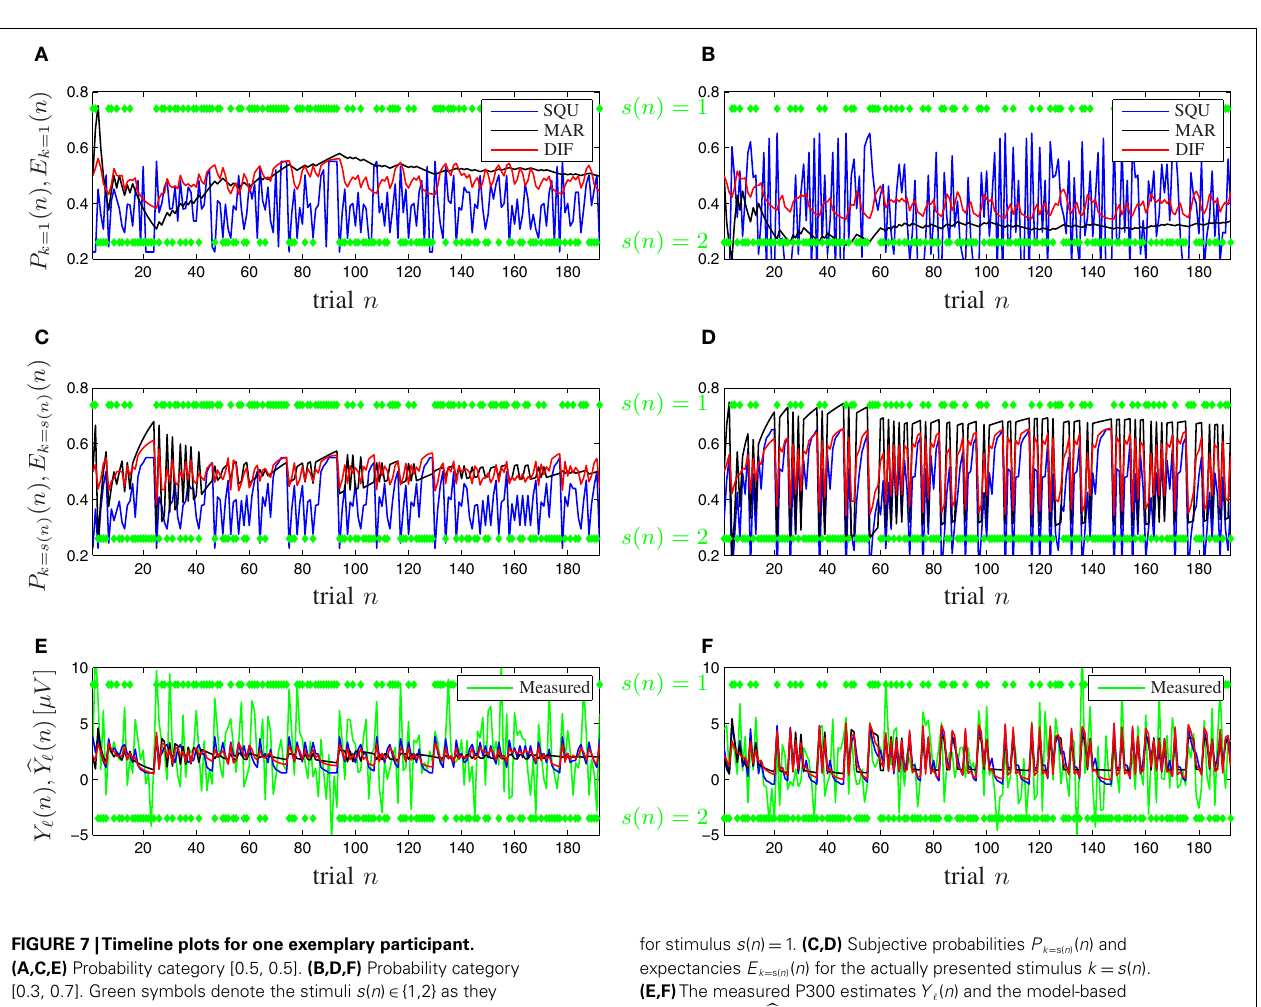
FIGURE 7 |Timeline plots for one exemplary participant. (A,C,E) Probability category [0.5, 0.5]. (B,D,F) Probability category [0.3, 0.7]. Green symbols denote the stimuli s ( n ) ∈ {1,2} as they occurred. (A,B) Subjective probabilities P k = 1 ( n ) and expectancies E k = 1 ( n ) from (5), (7), and (9) for MAR, SQU, and DIF, respectively,